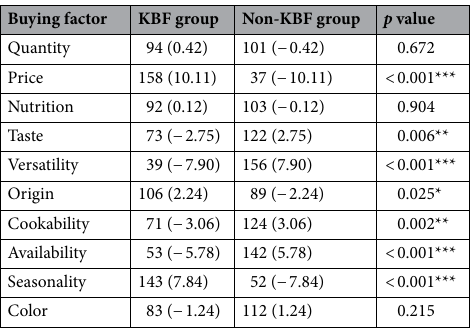
Table 2. Number of participants in the KBF and non-KBF groups for each buying factor at the time of vegetable purchase. Numerical values in parentheses are adjusted standardized residuals, and p values (two- sided) are results of residual analyses. *** p < 0.001, ** p < 0.01, * p < 0.05.